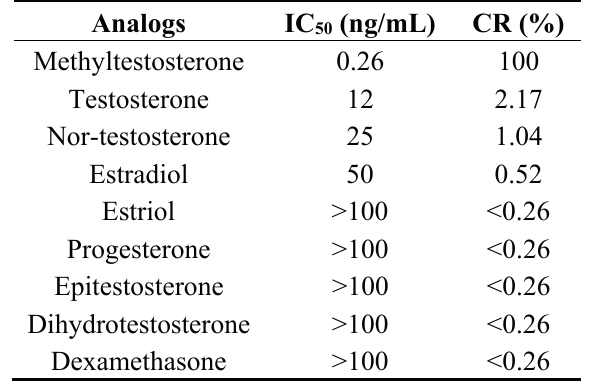
Table 1. The cross-reactivity of anti-MT mAb with